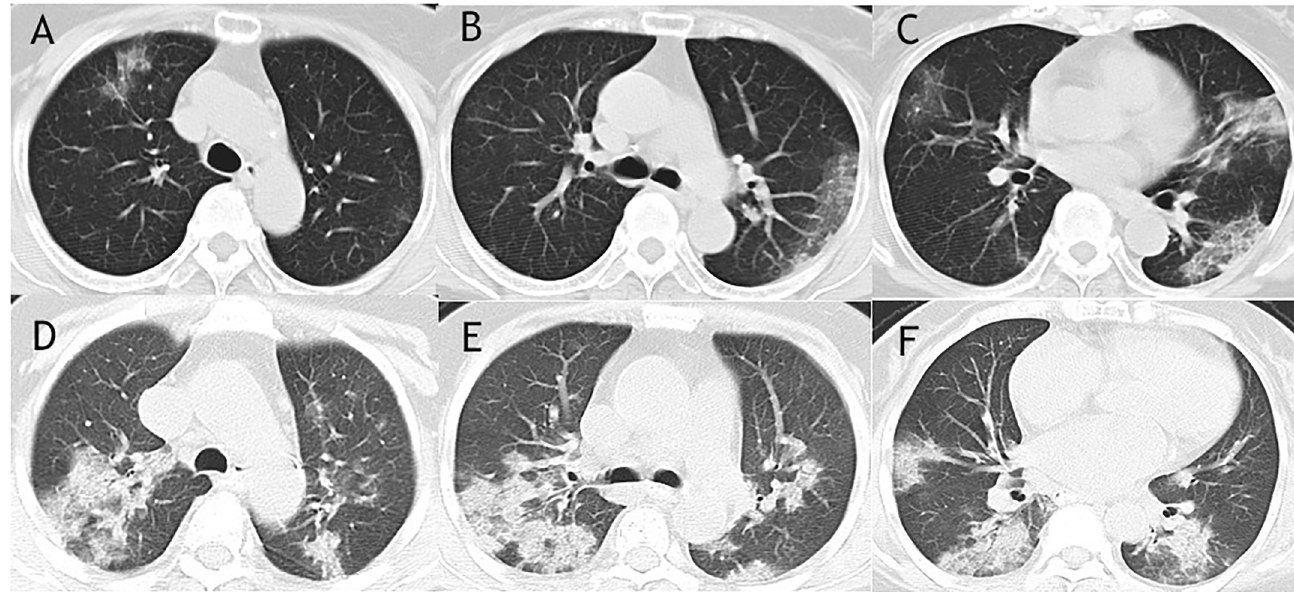
Fig 2. Comparison of CT images between survival group and mortality group. CT images of a 76-year-old woman from survival group showed pure ground glass opacities with predominant peripheral distribution in middle and lower lung zones (A-C). Air bronchogram, together with extensive of consolidations and ground glass opacities were found in the CT images of a 72–year-old woman from mortality group (D-F).